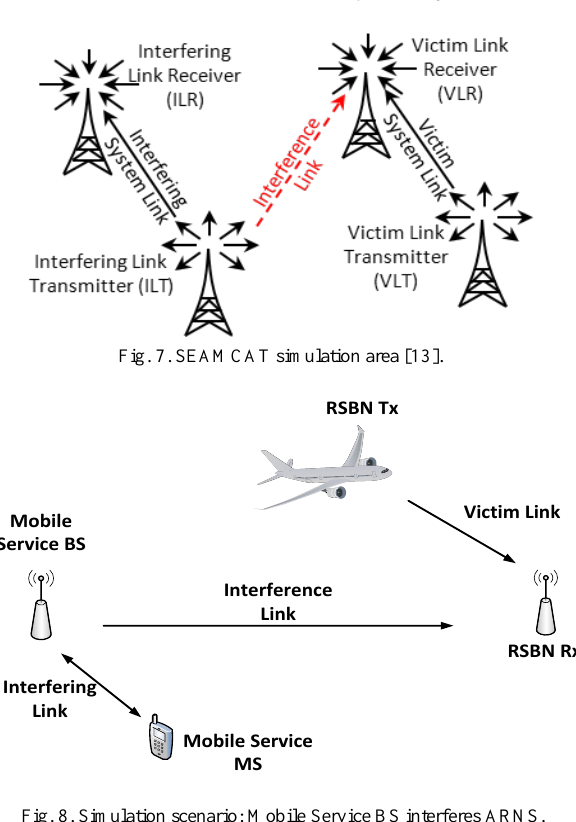
Fig. 8. Simulation scenario: Mobile Service BS interferes ARNS.